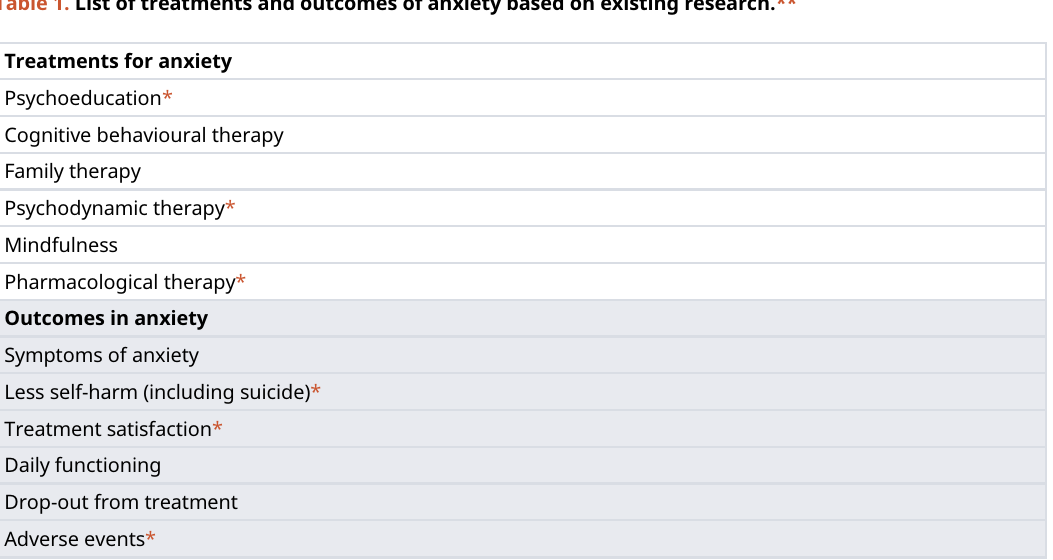
Table 1. List of treatments and outcomes of anxiety based on existing